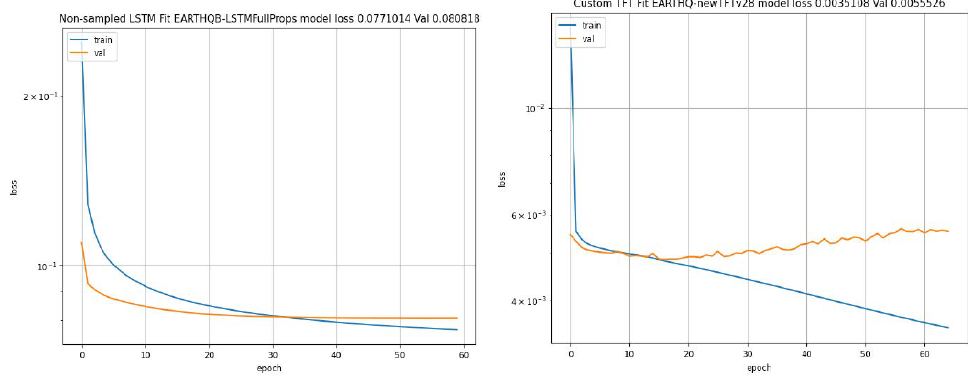
Figure 11. Epoch dependence of training and validation loss for LSTM ( left ) and TFT ( right